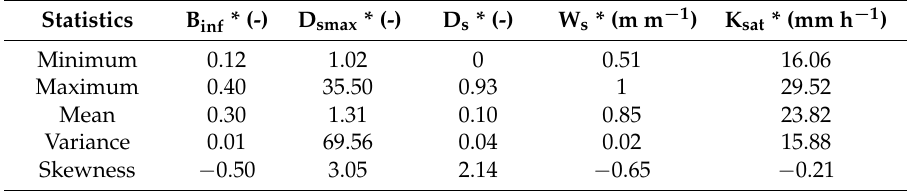
Table 1. Summary of posterior distribution for each parameter.